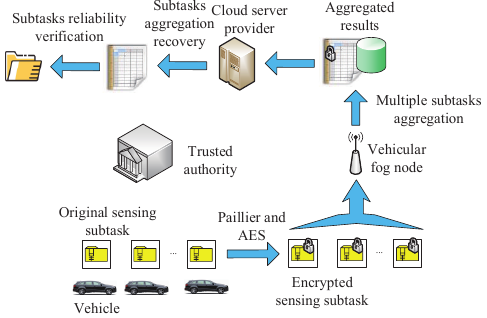
Figure 7. The architecture of the secure task recomposition